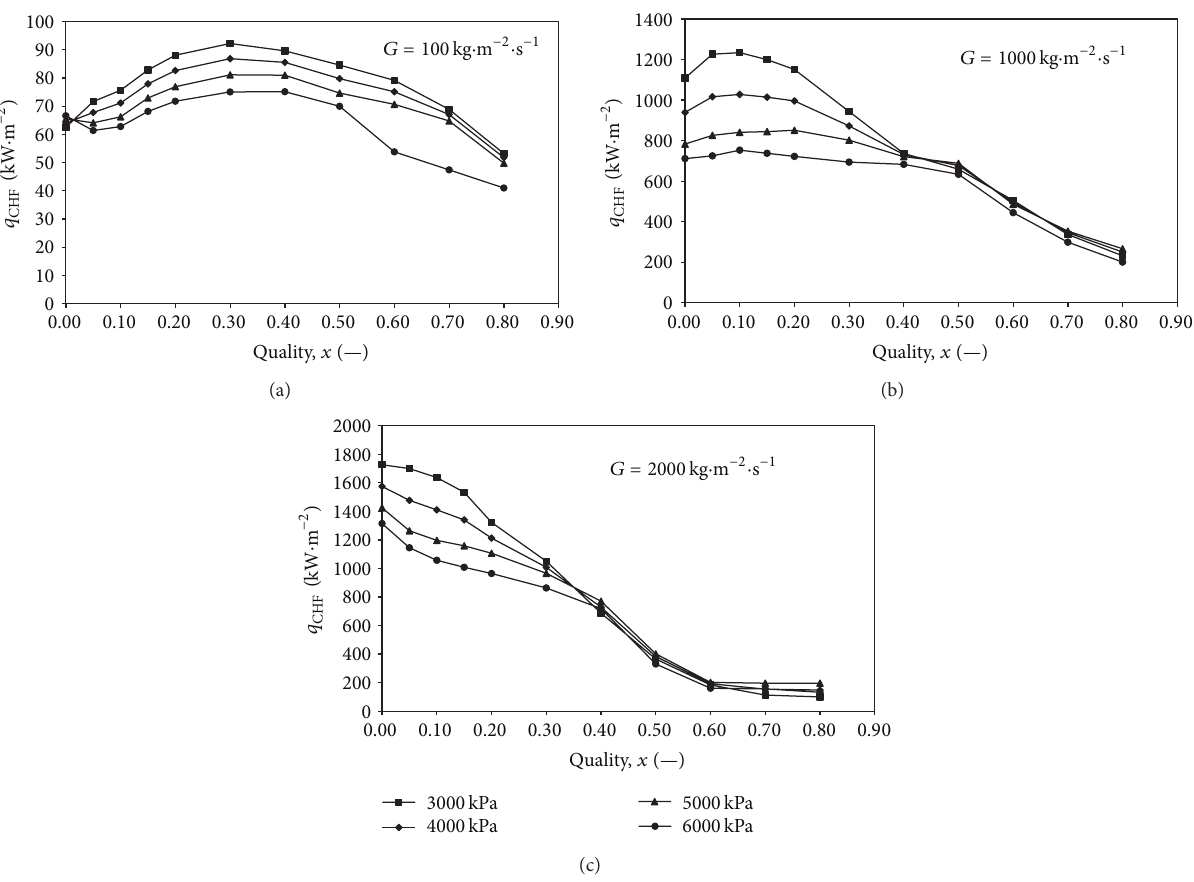
Figure 6: Effect of pressure on CHF for horizontal flow of water in 67 mm diameter tube as predicted by